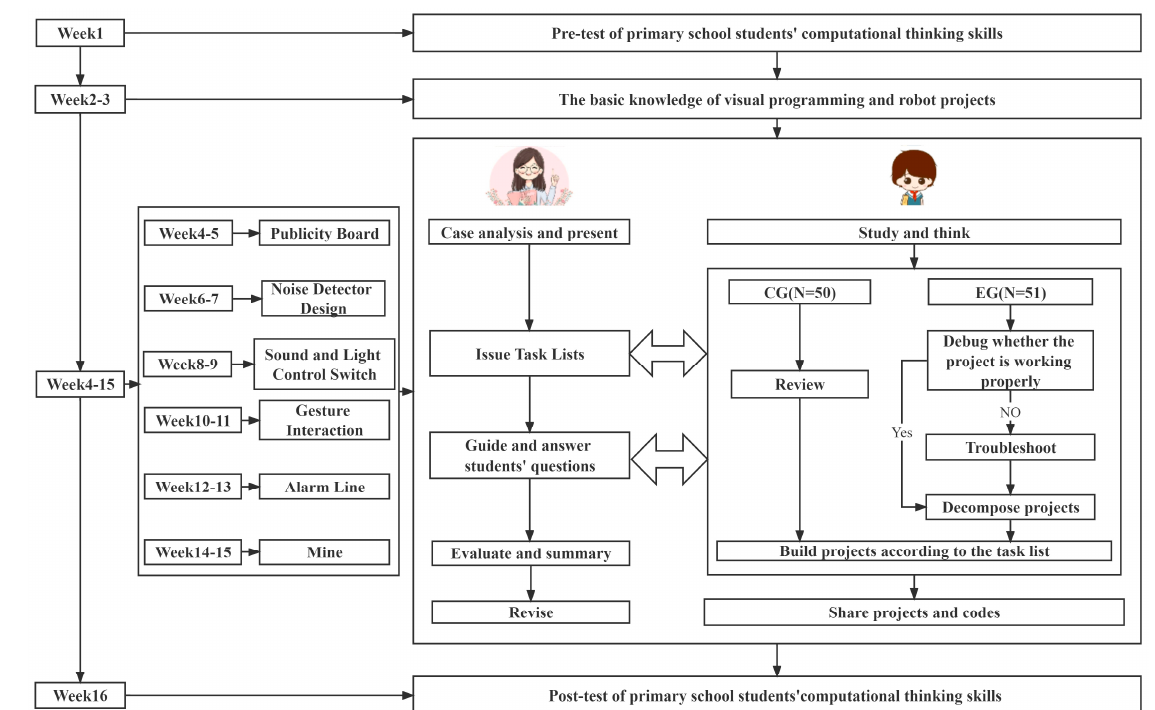
Figure 4. Experiment design and procedure.